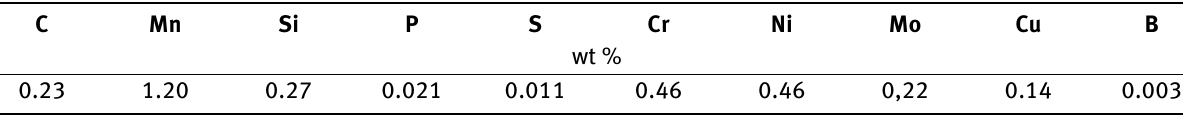
Table 1: Average chemical composition of the analysed